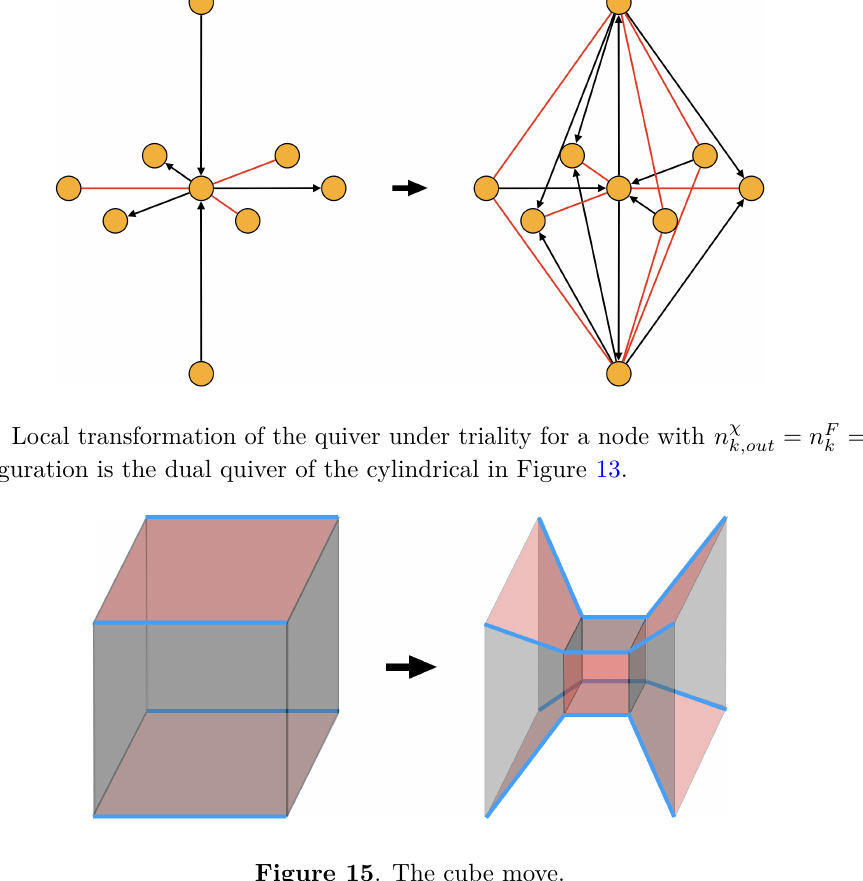
Figure 15 . The cube